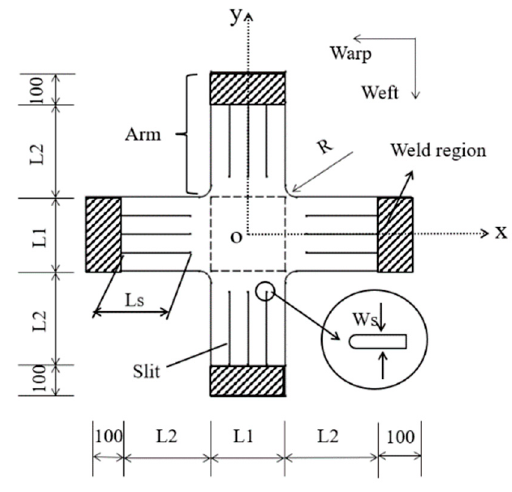
Figure 2. Geometry of base cruciform specimen (Units: mm).